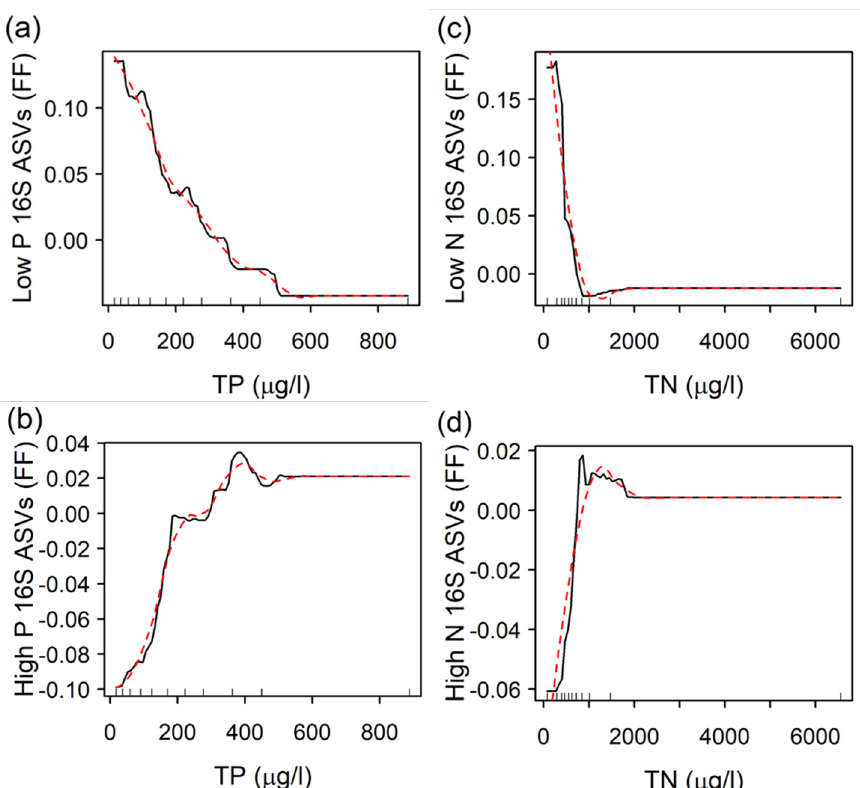
Figure 4. Partial dependence plots from boosted regression trees showing responses of bacterial metrics to TP( a , b ) or TN ( c , d ) while controlling for the average effect of other variables. FF = fitted functions. Rug plots show deciles of predictor values.